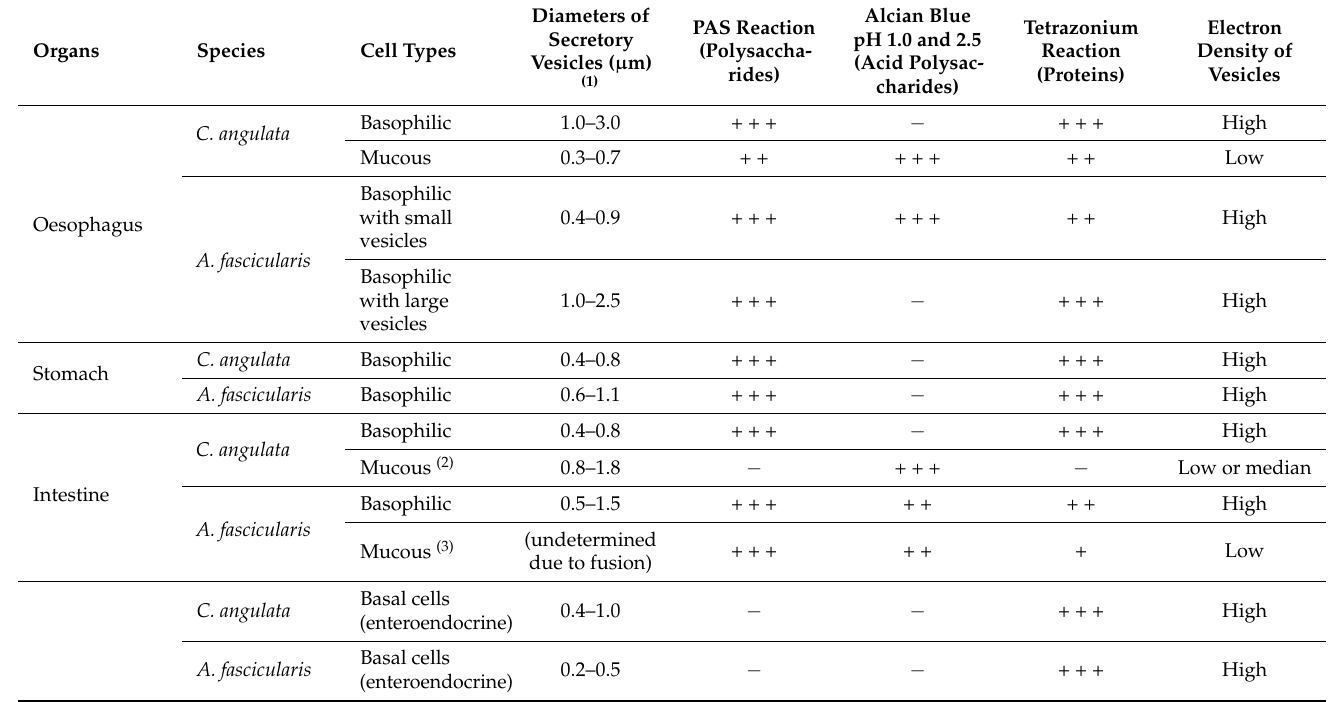
Table 1. Characterization of secretory cells of the digestive tract of C. angulata and A. fascicularis